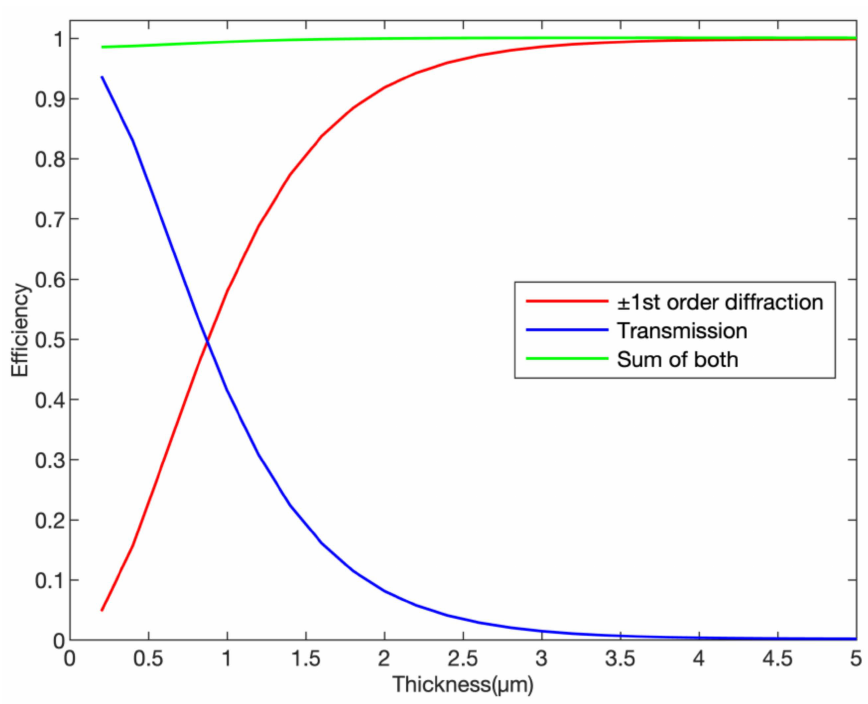
Figure 7. Simulated efficiency for ± 1st order diffraction and transmission as a function of mate- rial